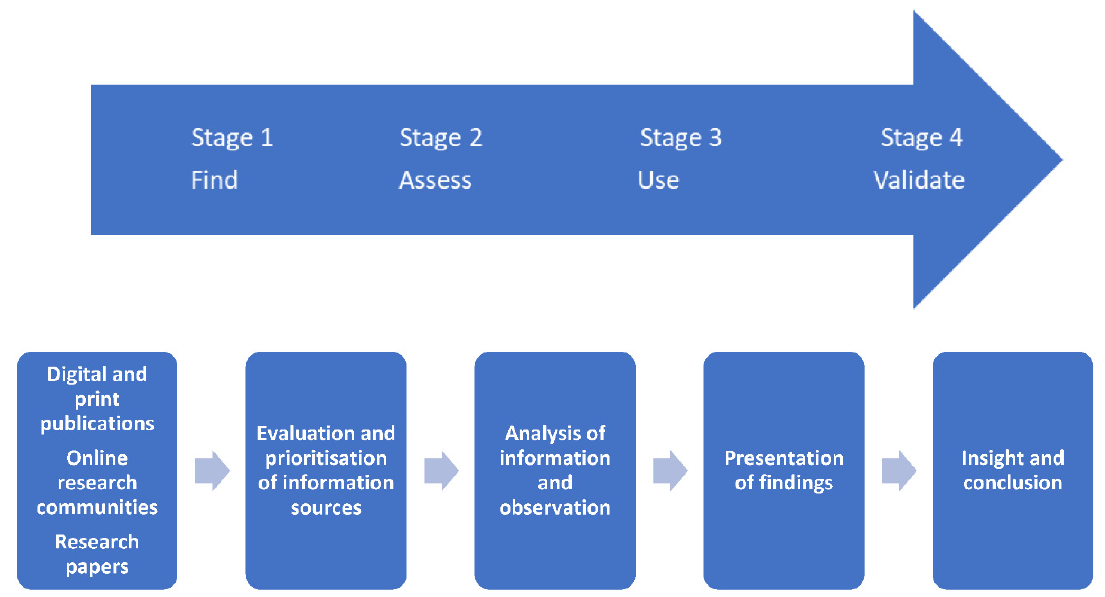
Figure 2. Scheme of the research method.